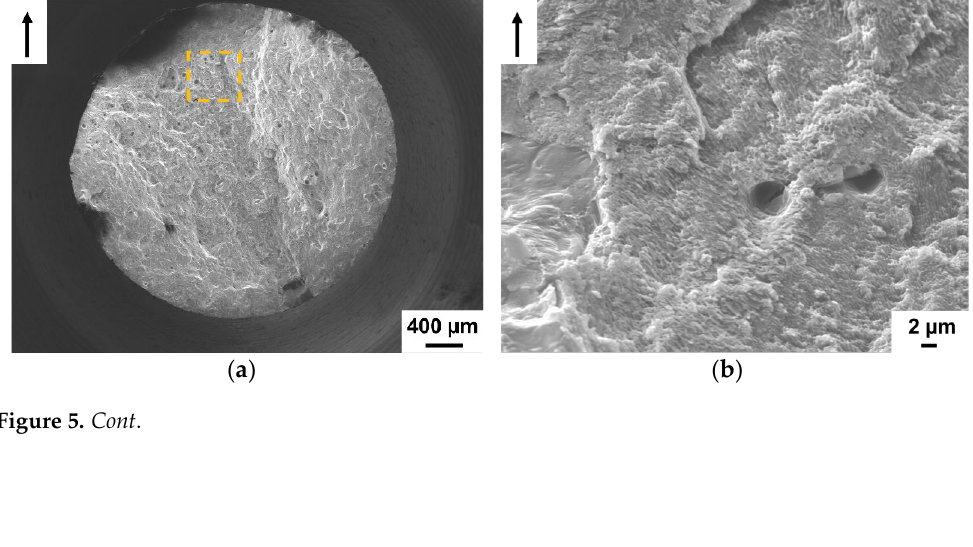
Figure 4. ( a ) Evolution of yield strength, ultimate tensile stress, and ( b ) fracture strain as a function of building area. For each building area and orientation, plotted values resulted from three specimens tested.